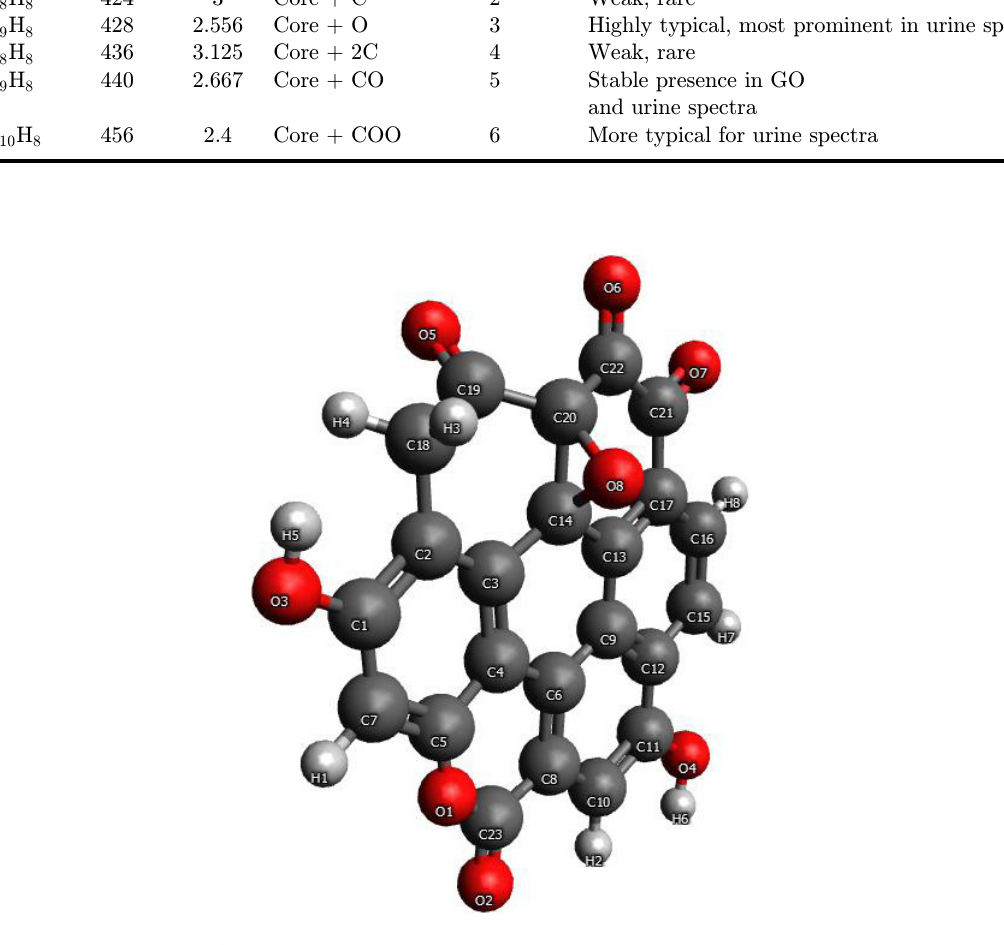
Fig. 9. A possible model of a MALDI core particle C 23 O 8 H 8 with numbered atoms of carbon C, oxygen O and hydrogen H.